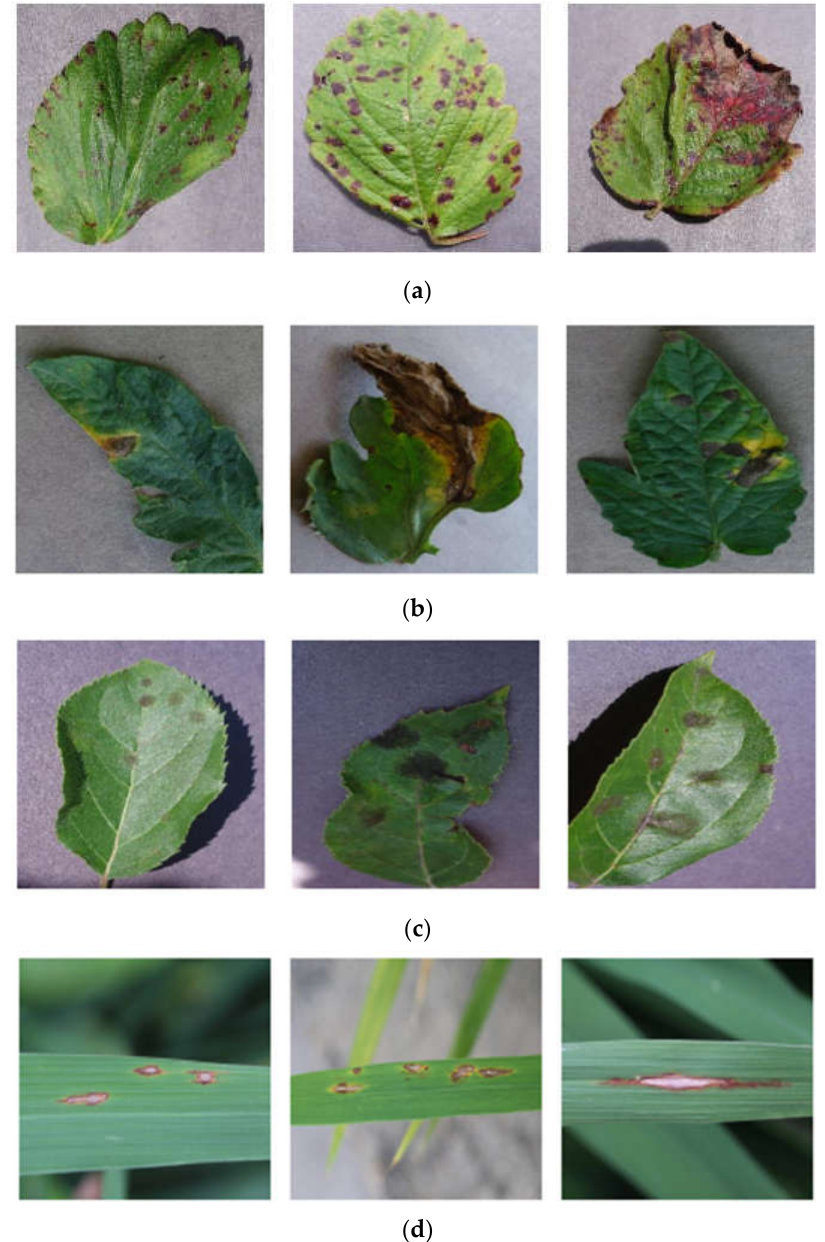
Figure 1. Four diseases’ partial dataset of akihime, solanum lycopersicum, malus pumila mill, and oryza sativa. ( a ) S_BlackRot: Akihime leaf blight; ( b ) S_Scorch: Solanum lycopersicum early blight fungus; ( c ) S_EarlyBlig: Malus pumila Mill Scab of cucurbits; ( d ) S_Magnaporthe: oryza sativa magnaporthe grisea.